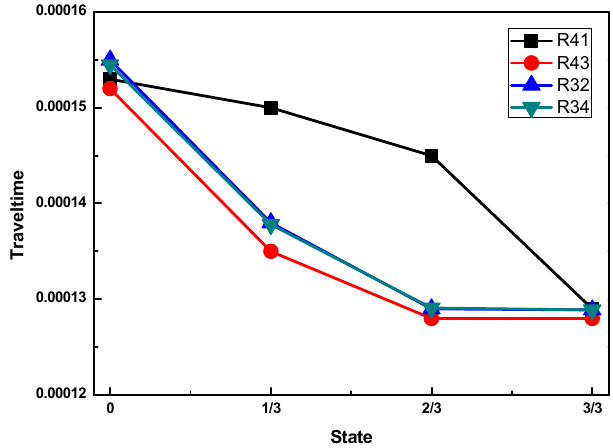
Figure 10. The arrival time of different concrete infill conditions from the experimental study.